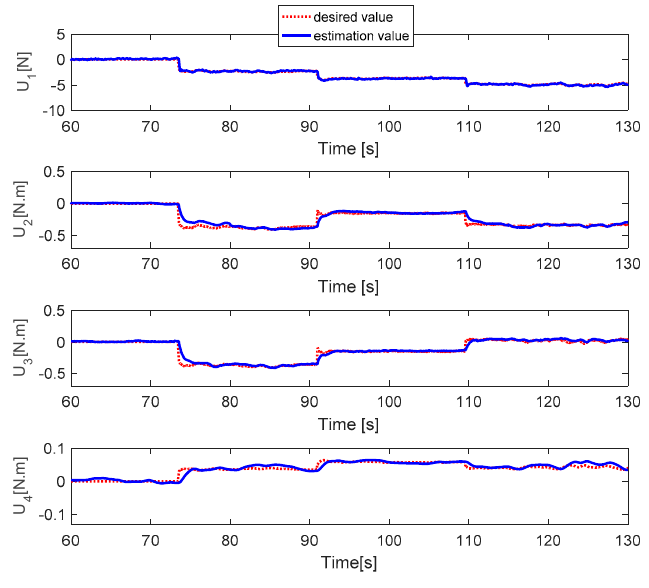
Figure 13. Fault estimation of control inputs.